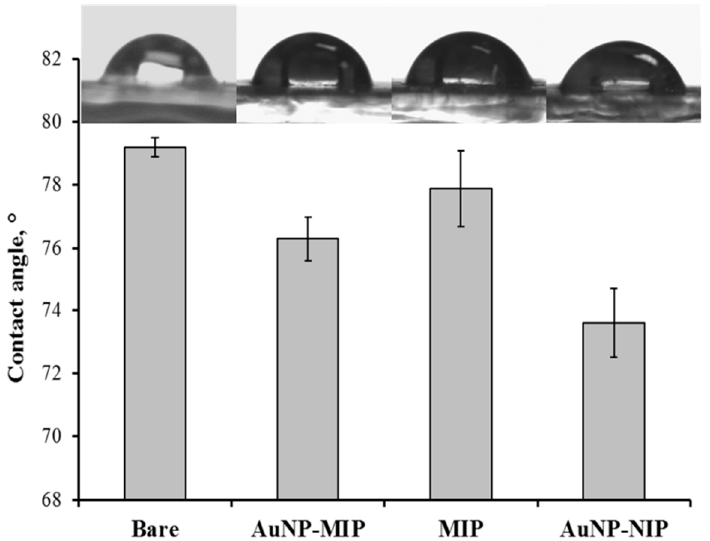
Figure 3. Contact angle values and images of bare, AuNP-MIP, MIP, AuNP-NIP sensors to depict hydrophilicity.